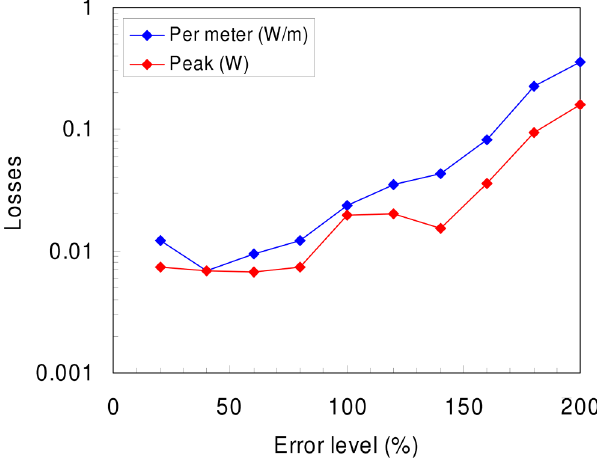
FIG. 9. (Color) The deuteron losses in the RFQ in respect to the error level.